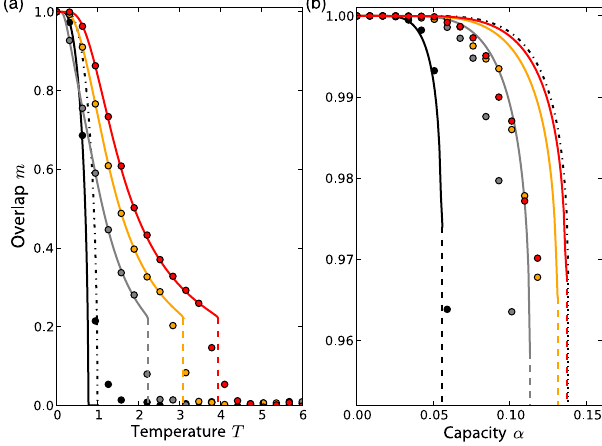
11. Network convergence despite more asymmetric cou- FIG. 12. Memory performance of the stochastic Hopfield plings. Parameters are the same as in Fig. 4, with Var ½ w (cid:1) ¼ 0 . 5 . model with nonlinear dendritic branches and more asymmetric Simulations are performed with identical initial states, topology, couplings. Parameters are the same as in Fig. 5, with and order of updates. As the linear Hopfield model is not affected Var ½ w (cid:1) ¼ 0 . 5 . The figure compares analytical results (solid lines) by Var ½ w (cid:1) , its energy (solid black line) decreases monotonically for linear summation (black lines and symbols) and nonlinear and reaches a fixed point. For the extended Hopfield model with summation with dendritic spike strengths D ∈ f 0 . 4 ; 0 . 6 ; 0 . 8 g nonadditive dendrites and more asymmetric couplings, the (gray, orange, and red lines and symbols) and symmetric energy decreases (solid red line) with rare events of increasing couplings to simulation results (circles) for asymmetric cou- energy (red squares) due to deviations from the mean-field plings. Results for linear input summation with Θ ¼ 0 are approach or asymmetric couplings [cf. the discussion of included for comparison (dash-dotted black line). (a) The overlap Eq. (27)]. The convergence of the system is preserved (checked P m versus the temperature T for a small load α ¼ N − 1 ≈ 0 . The N v − v 0 for 1000 runs). The Hamming distance d ¼ 1 n j n n ¼ 1 j 2 N more asymmetric couplings change m only slightly, and the (dashed red line) between the systems shows that they settle into simulation results agree well with the analytics of the symmetric different couplings. (b) m versus α for T ¼ 0 . The stronger asymmetries impair the memory function, and the overlap m displays a drop at lower loads α compared to the symmetric ð v 1 ; … ; v N Þ with pattern p ¼ 1 , i.e., ð ξ 1 1 ; … ; ξ 1 N Þ . The